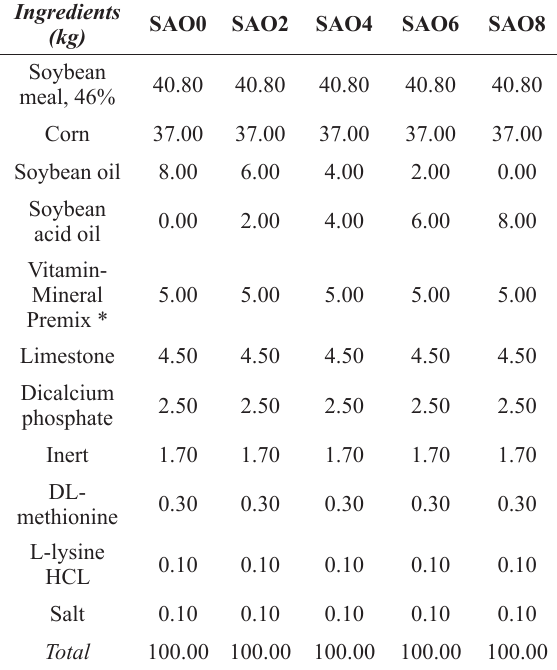
Experimental diets of quails fed growing levels of soybean acid oil (SAO) in replacement of soybean oil (SO). Ingredients (kg)